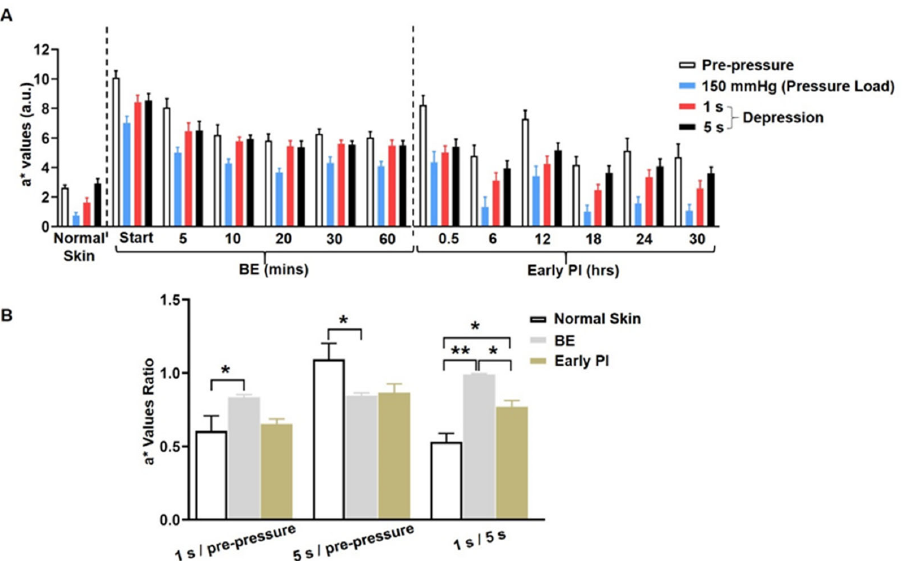
Figure 6. Quantitation of ischemia by the CRTT: ( A ) a* values at certain times post-decompression in the three groups. In this image, 1 s represents the a* values at 1 s after depression, and 5 s represents the a* value at 5 s after depression; ( B ) the ratio of refill time was expressed as above. The a* values were recorded at pre-pressure and 1 s and 5 s after depression. Then, the a* values in the normal skin group, at 0 min post-decompression in the BE group, and 6 h post-decompression in early PI group were chosen. In this image, 1 s after depression/pre-pressure and 5 s after depression/pre-pressure represent the refill time, and 1 s/5 s represents a delayed refill time. * p < 0.05, ** p < 0.001. n = 8.